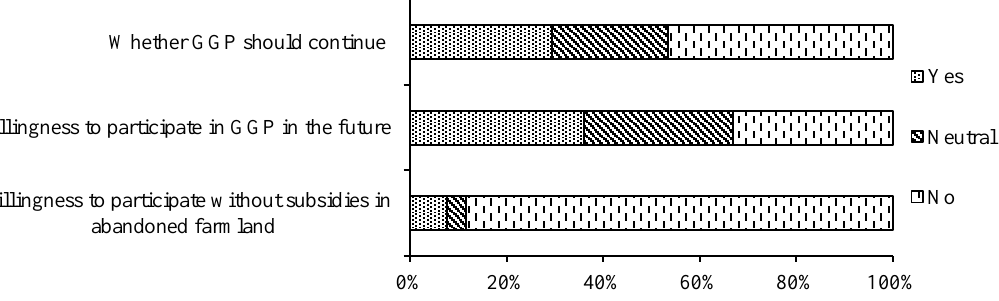
Figure 2. Farmers’ willingness to participate in the GGP in the future.